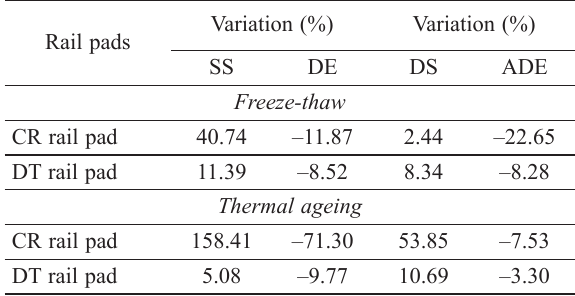
Table 4. Variation in the static and dynamic performance of the rail pads after freeze-thaw and thermal ageing processes. Rail